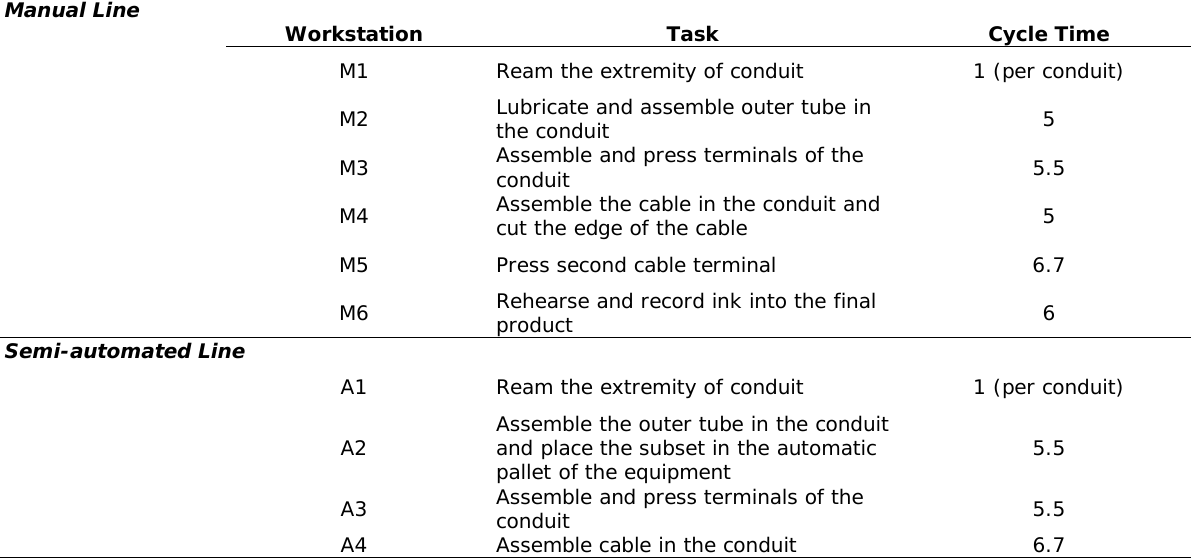
Table 1. Characteristics of the manual and semi-automated production lines (n=7)